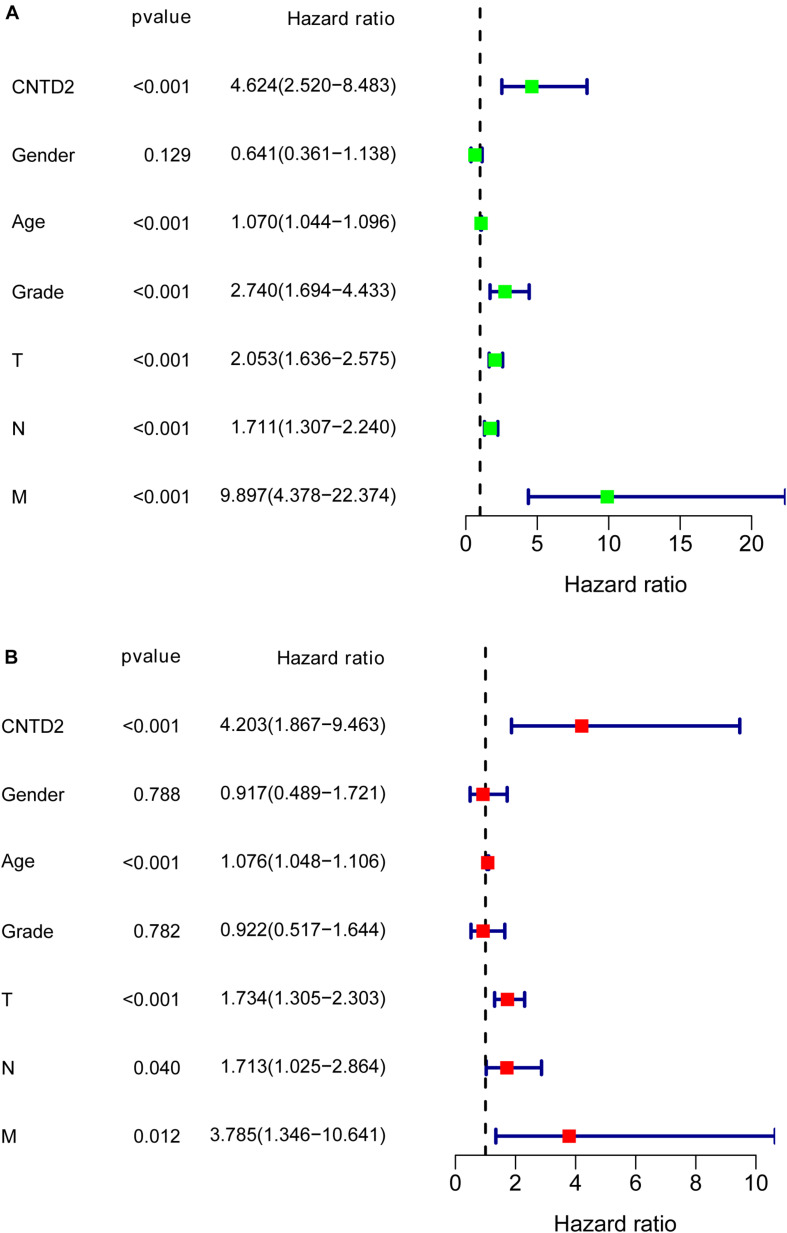
Cox regression analysis for the overall survival rates of bladder cancer patients.